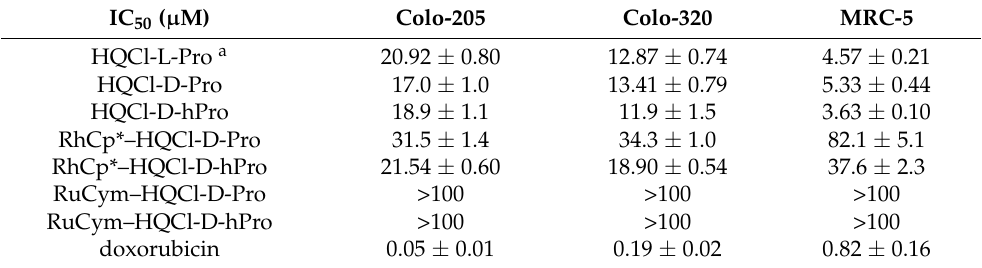
Table 1. In vitro cytotoxicity expressed as IC 50 values for the ligands (HQCl-D-Pro, HQCl-D-hPro) and their RhCp* and RuCym complexes in Colo-205, Colo-320 human colon adenocarcinoma and MRC-5 human lung fibroblast cell lines in comparison with HQCl-L-Pro. (Incubation time: 72